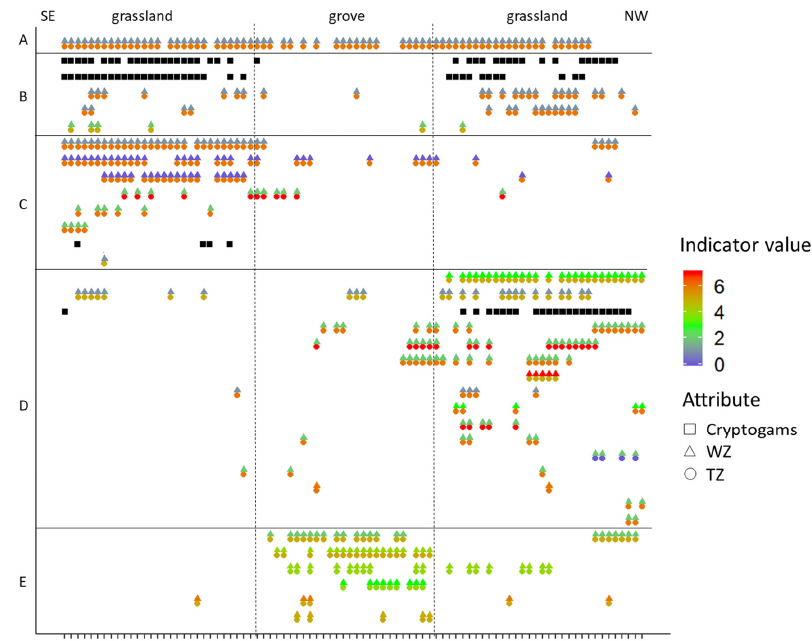
Figure 8. Distribution of the species along the SE–NW (Southeast–Northwest) transect in July 2018, together with the Zólyomi ecological indicator values, which quantify the temperature (TZ) and moisture (WZ) optimums for the plant species. Horizontal bars indicate coexisting species groups: (A) ubiquitous species; (B) species occurring in the grassland; (C) species occurring on the south-eastern side of the grassland; (D) species occurring on the north-western side of the grassland; (E) species occurring in the grove. List of species is shown in Table 1.